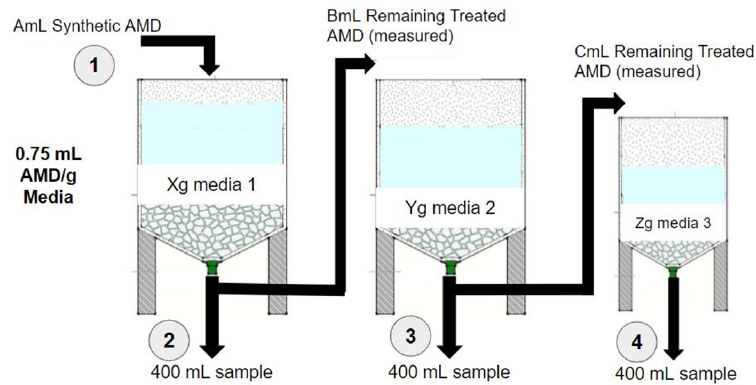
Figure 1. Schematic diagram of successive process train set-up.